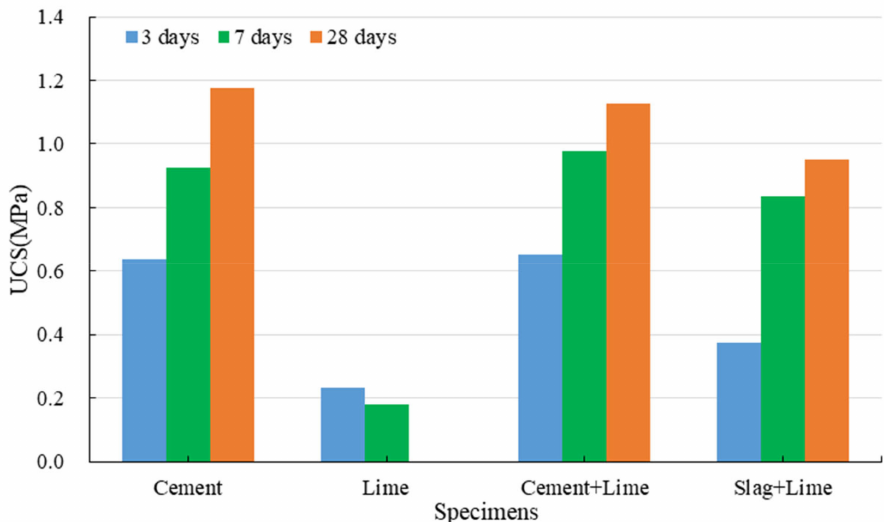
Figure 9. Strength development of specimens under the immersion conditions.